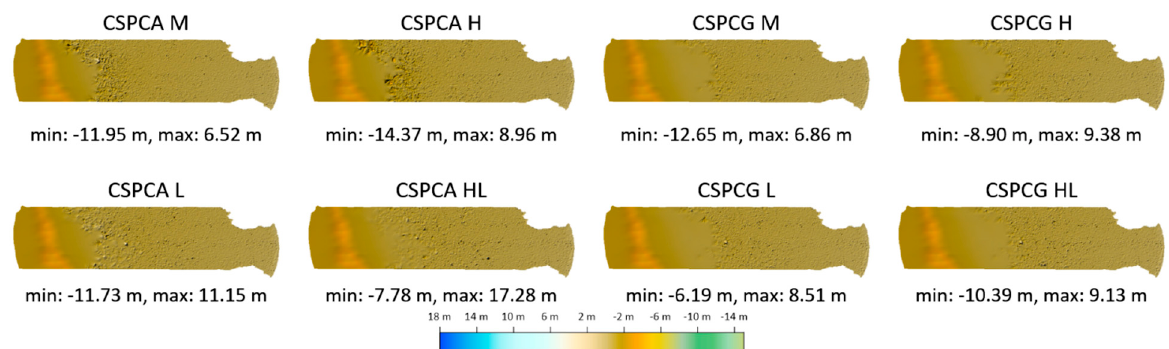
Figure 23. Models obtained by the RBF method.